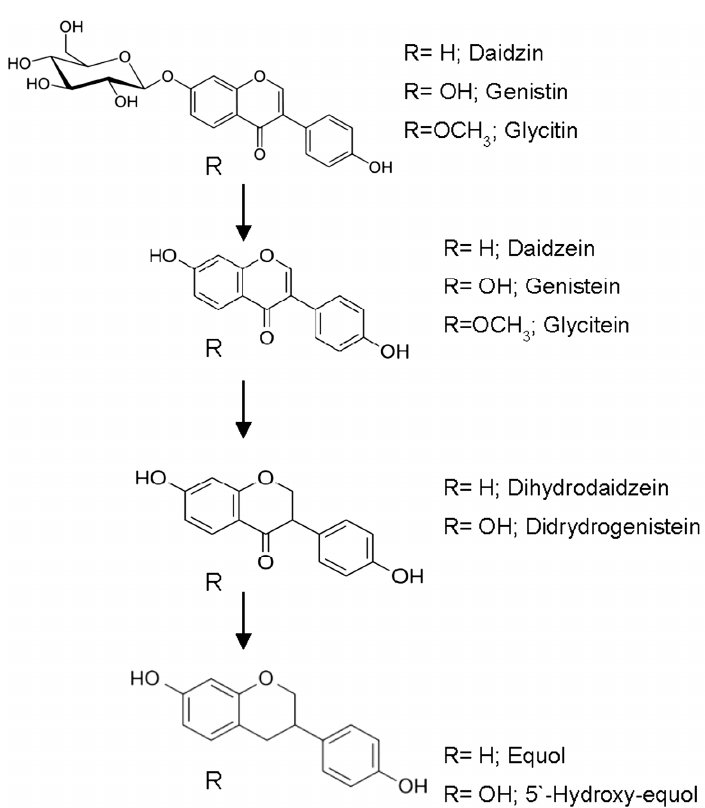
Figure 1. Metabolic pathway of isoflavones.